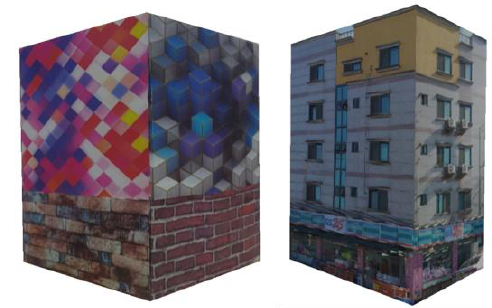
Figure 8. Model extracted from stereo